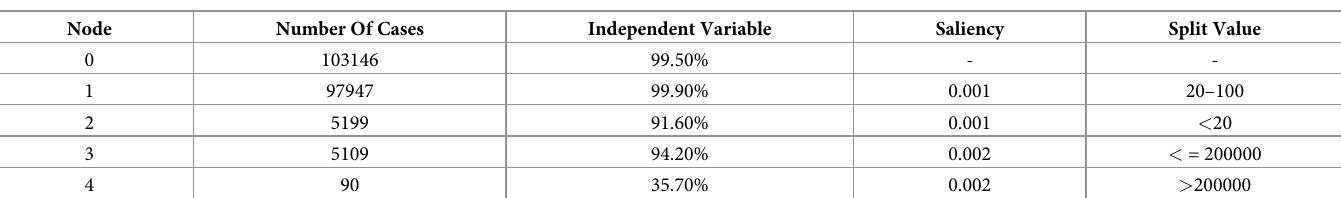
Table 4. Number of CART models.